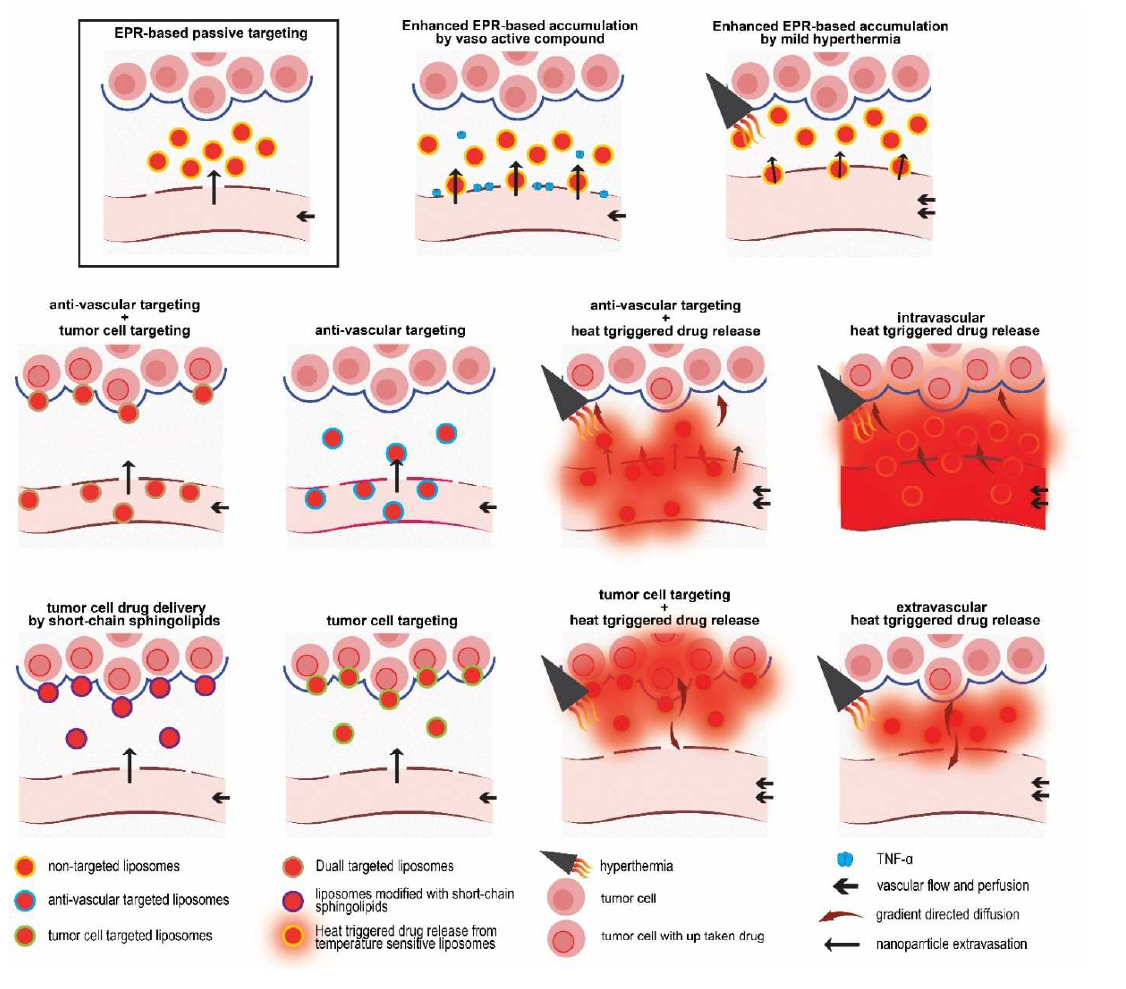
Figure 2. Multifaceted strategies employed at the Nanomedicine Innovation Center Erasmus to